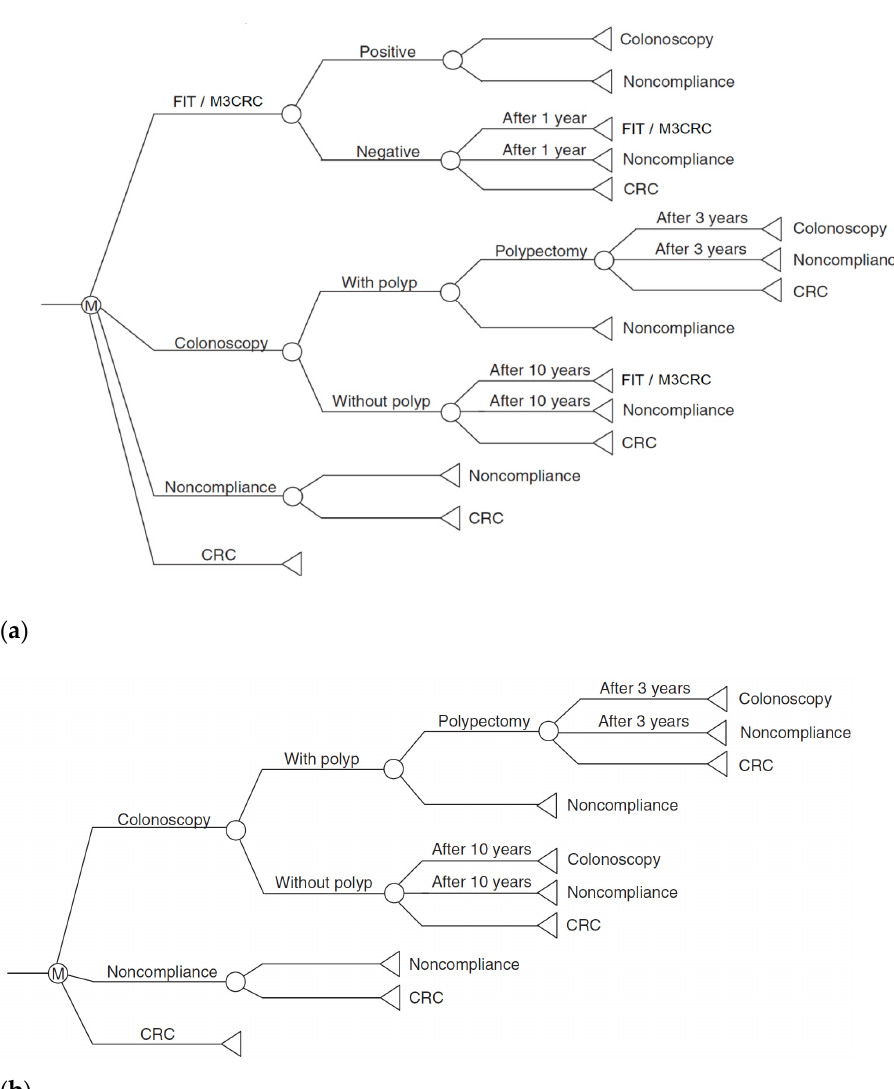
Figure 1. Markov process on strategies using FIT, M3CRC and colonoscopy as primary screening test. They are listed as: ( a ) FIT/M3CRC; ( b ) Colonoscopy. CRC: colorectal cancer; FIT: fecal immunochemical tests. The figure described transitions of screening participants to various stages, and the model included annual mortality. Subjects were followed up from 50 to 75 years.